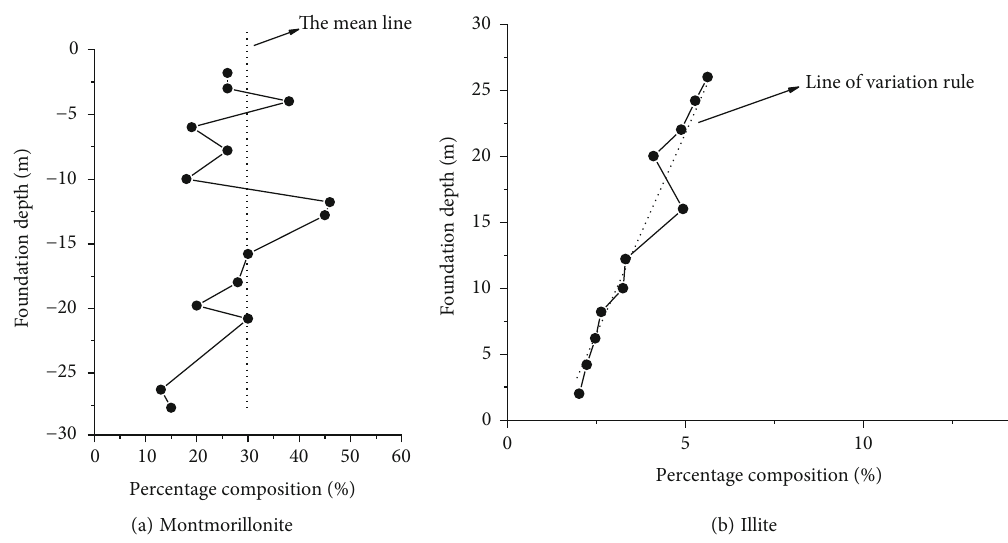
Figure 7: Distribution of montmorillonite and illite along foundation depth.